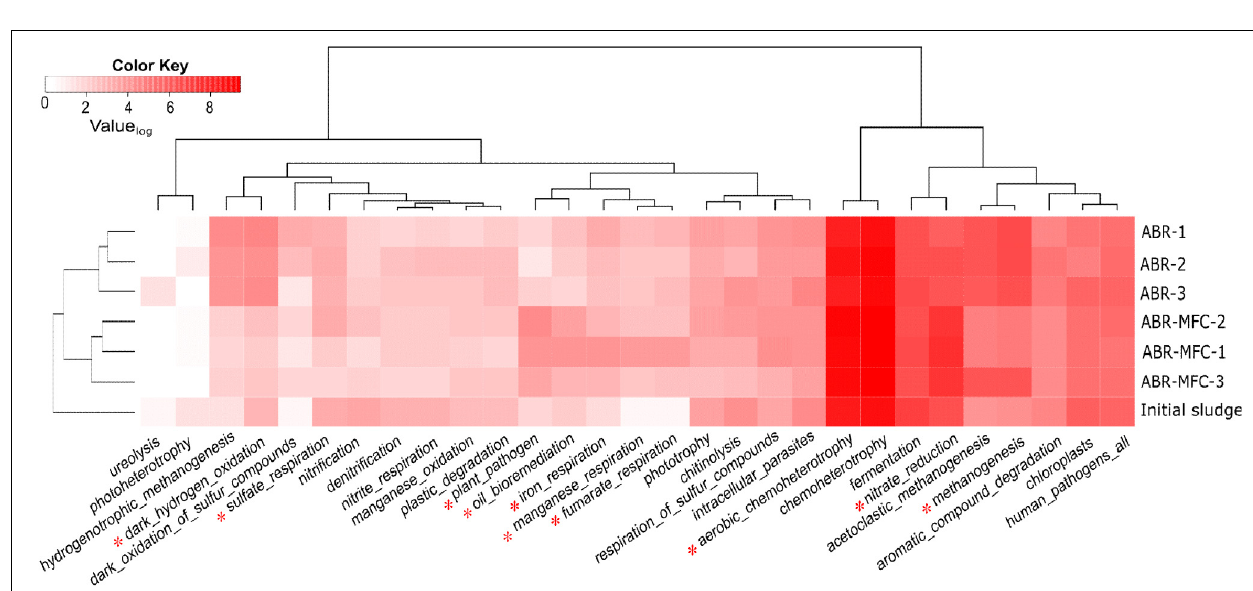
FIGURE 4 | Microbial and DHA activity in chamber 3 of ABR and MFC-ABR. (A,C) Microbial activity of the sludge in MFC-ABR and ABR, respectively; (B,D) microbial activity of the biofilms on carbon fires of MFC-ABR and ABR, respectively. (E) DHA activity of the sludge in different chambers of MFC-ABR and ABR. Green color in (A–D) indicates microbial cells have high metabolism activity and intact cell membrane while red color indicates microbial cells with low metabolism activity and damaged membrane. Scale bar indicates 10 µ m.